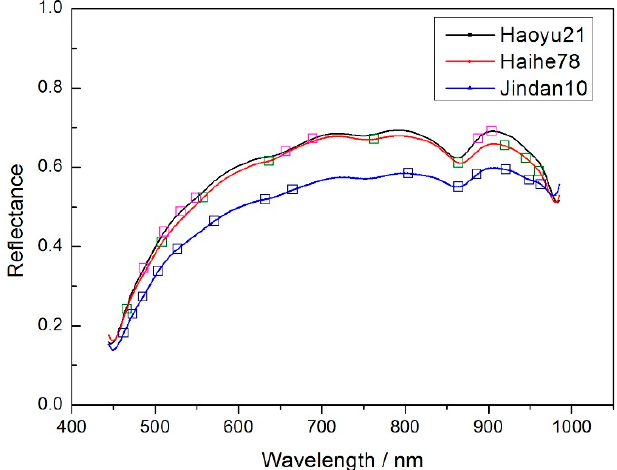
Figure 3. The description of the selected wavelengths by 5-3 smoothing pretreatment and the SPA method for the three varieties.